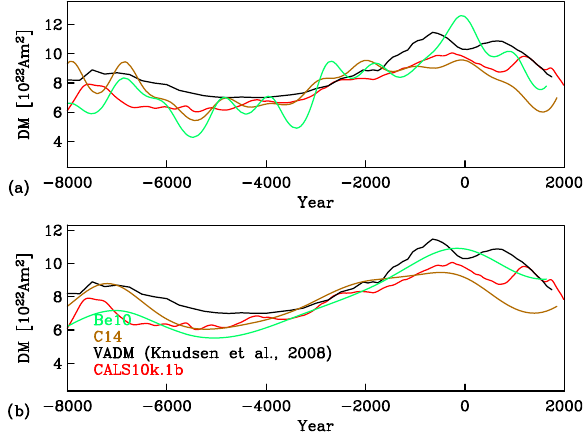
Fig. 5. Dipole moment estimates based on 14 C (brown) and 10 Be (green), low-pass filtered by 1/1000 yrs (a) and 1/3000 yrs (b), compared to CALS10k.1b (red) and the VADM reconstruction by Knudsen et al.